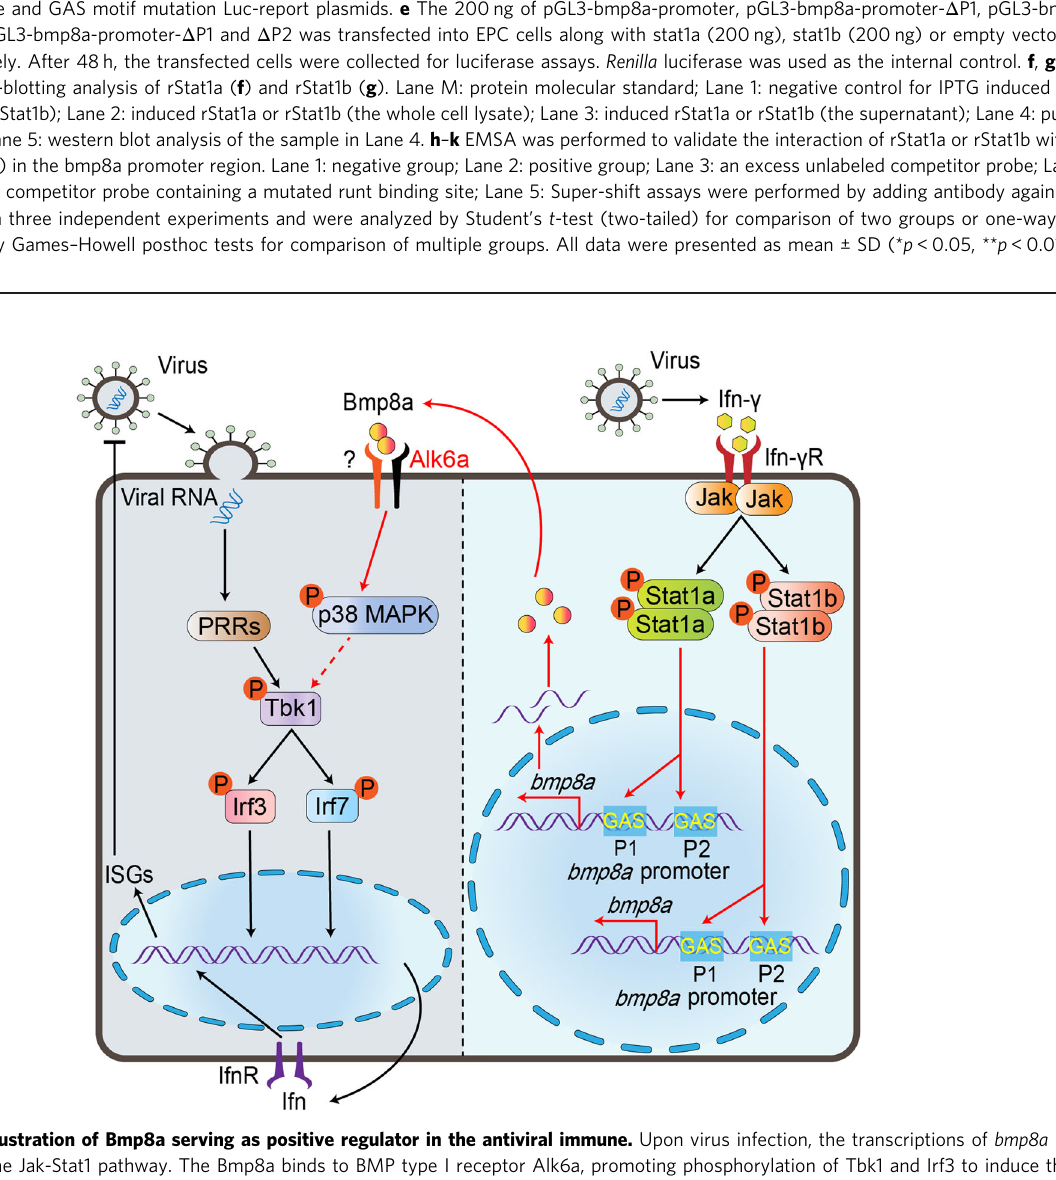
Fig. 8 Stat1 binds the GAS sites and activates the bmp8a transcriptions upon virus stimulation. a, b Expression of bmp8a mRNA in ZFL cells after transfected with stat1a- Δ C or stat1b- Δ C for 36 h ( a ) or 48 h ( b ). The expression of actb1 served as a control for the qRT-PCR. c Dual luciferase report assay was used to analyze the transcription abilities of Stat1a and Stat1b in activation of bmp8a in EPC cells. pGl3-bmp8a (200 ng) was transfected into EPC cells together with stat1a (200 ng), stat1b (200 ng), or empty vector (200 ng). After 48 h, the transfected cells were collected for luciferase assays. d Schematic drawing of wild-type and GAS motif mutation Luc-report plasmids. e The 200 ng of pGL3-bmp8a-promoter, pGL3-bmp8a-promoter- Δ P1, pGL3-bmp8a- promoter- Δ P2 or pGL3-bmp8a-promoter- Δ P1 and Δ P2 was transfected into EPC cells along with stat1a (200 ng), stat1b (200 ng) or empty vector (200 ng), respectively. After 48 h, the transfected cells were collected for luciferase assays. Renilla luciferase was used as the internal control. f , g SDS- PAGE and Western-blotting analysis of rStat1a ( f ) and rStat1b ( g ). Lane M: protein molecular standard; Lane 1: negative control for IPTG induced E . coli (without rStat1a or rStat1b); Lane 2: induced rStat1a or rStat1b (the whole cell lysate); Lane 3: induced rStat1a or rStat1b (the supernatant); Lane 4: puri fi ed rStat1a or rStat1b; Lane 5: western blot analysis of the sample in Lane 4. h – k EMSA was performed to validate the interaction of rStat1a or rStat1b with the